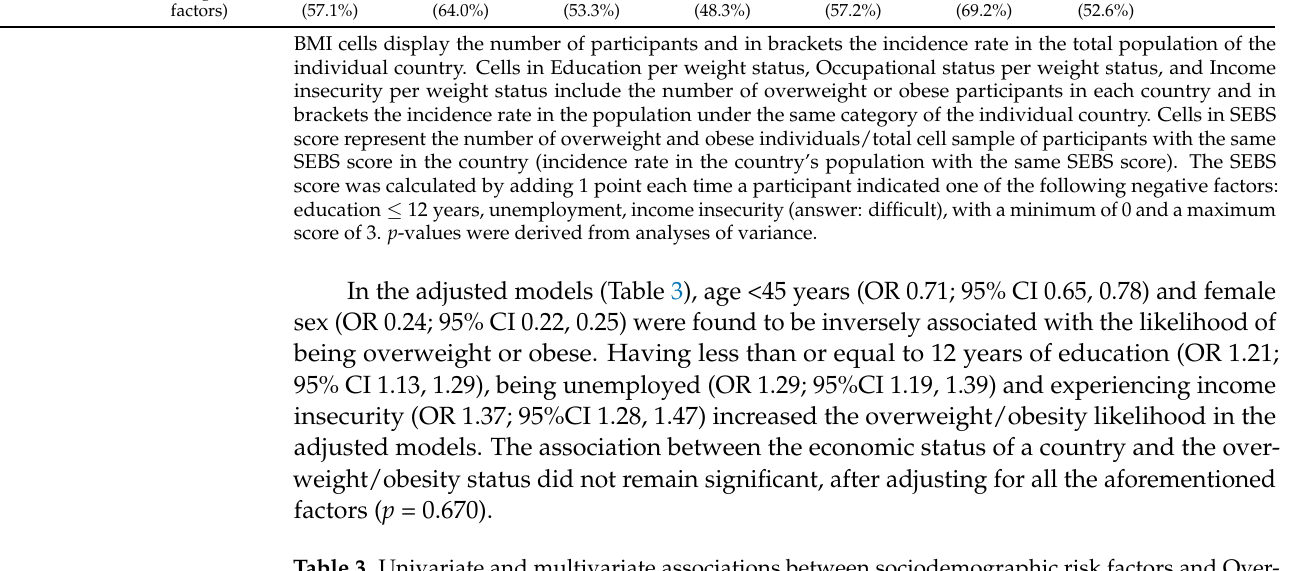
Table 3. Univariate and multivariate associations between sociodemographic risk factors and Over- weight/Obesity